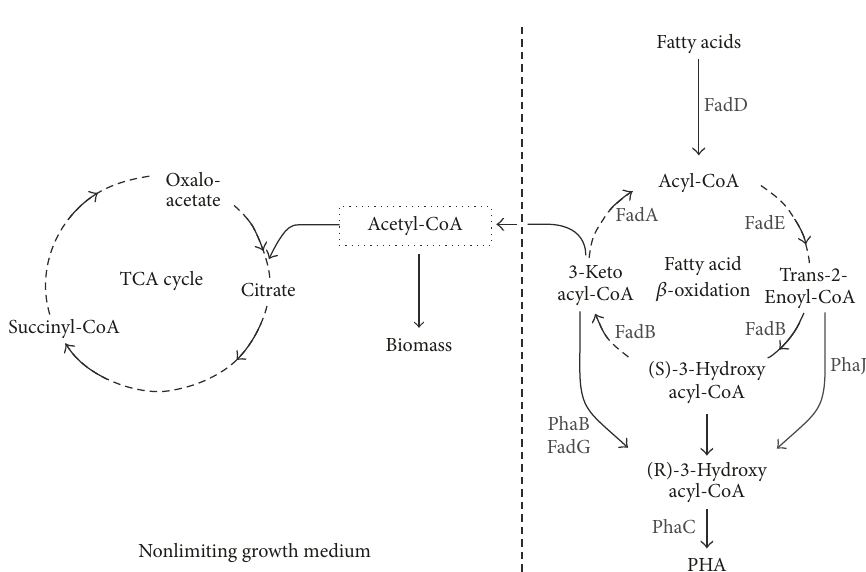
Figure 1: A simplified representation of fatty acid metabolism in Cupriavidus necator . In a nonlimiting growth media (left side), the tricarboxylic acid (TCA) cycle is active and the main product is biomass itself. Under unbalanced conditions (right side), caused by a noncarbon nutrient deficiency, C-source via fatty acid 𝛽 -oxidation flows towards the poly-R-hydroxyalkanoate (PHA) biosynthesis